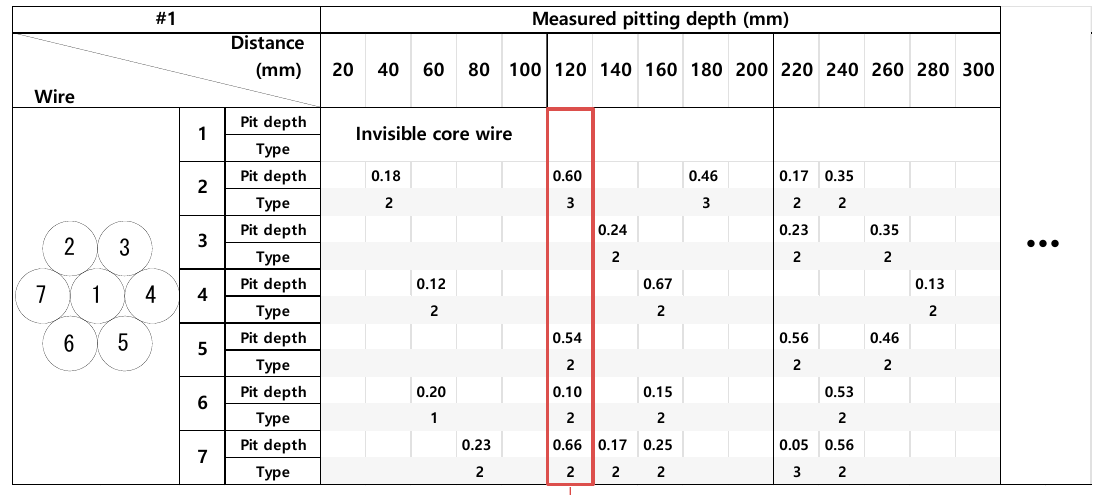
Figure 4. Three idealized pit configurations of corroded wires: ( a ) Type 1: hemispherical pit, ( b ) Type 2: concave pit, and ( c ) Type 3: planar pit.